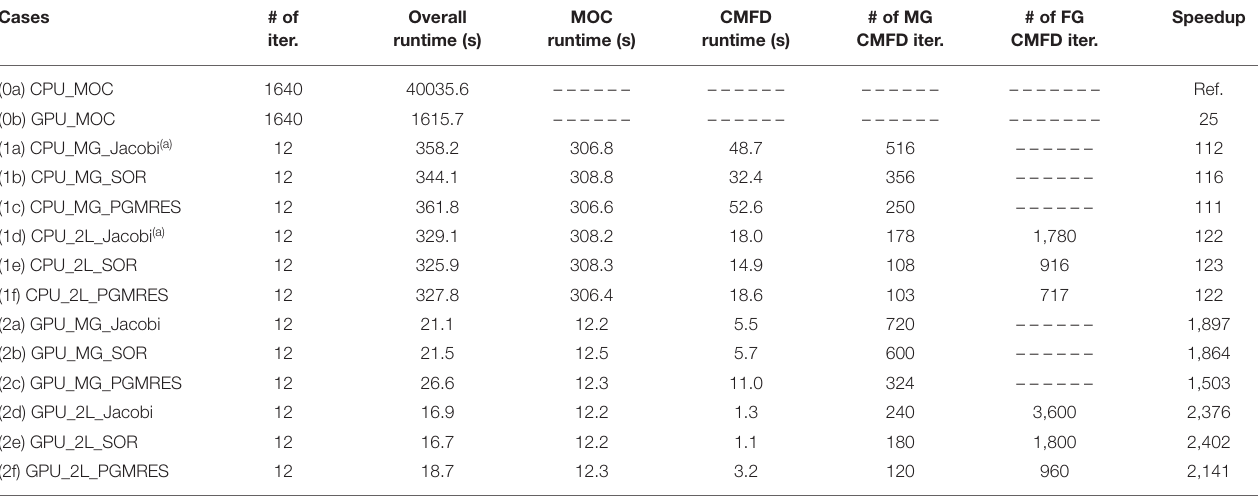
TABLE 2 | Results of the mock quarter-core problem with or without CMFD and GPU acceleration. Cases # of